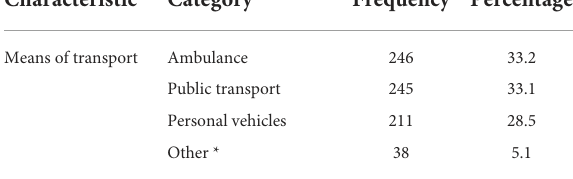
TABLE 1 Sociodemographic characteristics of women’s neonates admitted to North Shewa zone, public health hospital, Oromia region, Central Ethiopia, 2021.